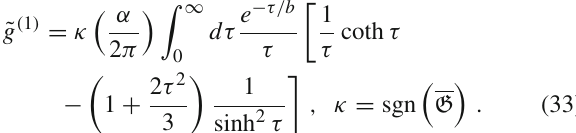
Fig. 2 Magnetic lines of force produced in a constant background by the static charge. The left pattern corresponds to the extended charge concentrated within the dashed circle, and the right pattern corresponds to the point charge [according to Eq. (26)]. Magnetic ( 1 ) ( x ) inside the charge is drawn following Eq. (24), and field B in ( 1 ) ( x ) following Eq. (25). In the limit R → 0, its outer part B out